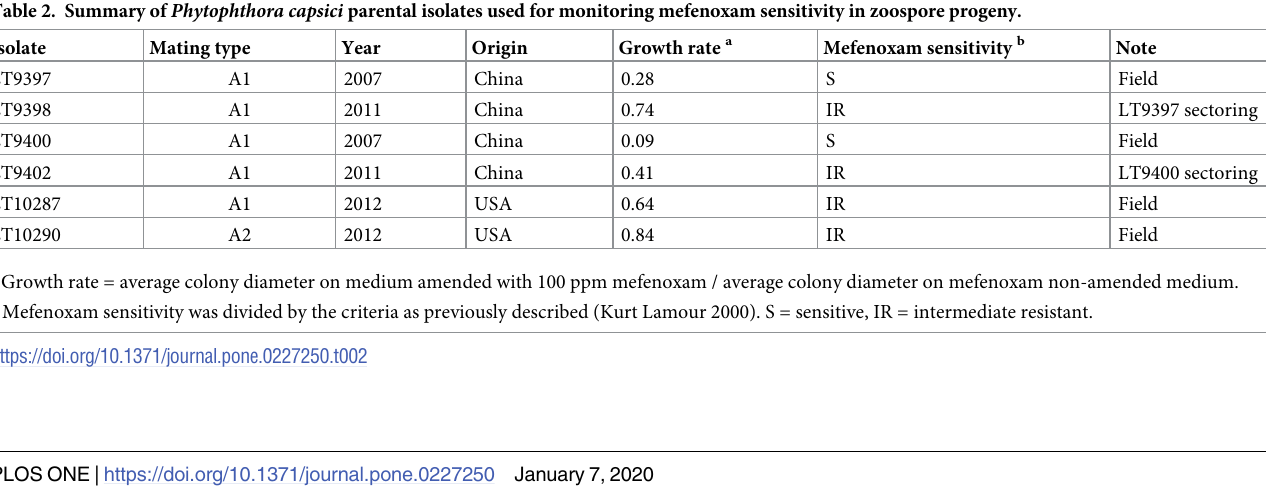
One of our most perplexing findings, based on the genome re-sequencing, was that heterozy- gous allele frequencies did not correspond directly with chromosome copy number (ploidy).